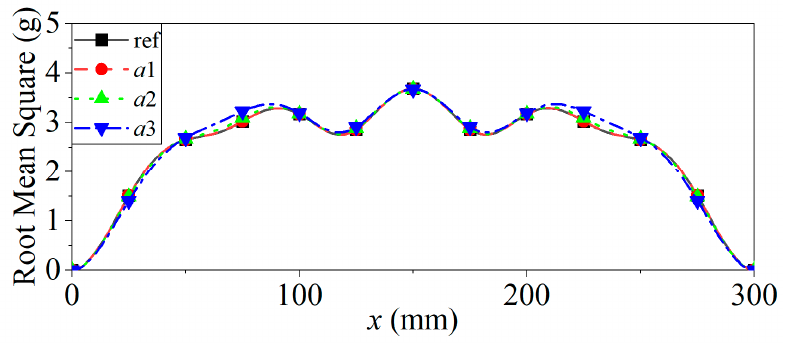
Figure 7. RMS of acceleration in the z-direction under different static loads.